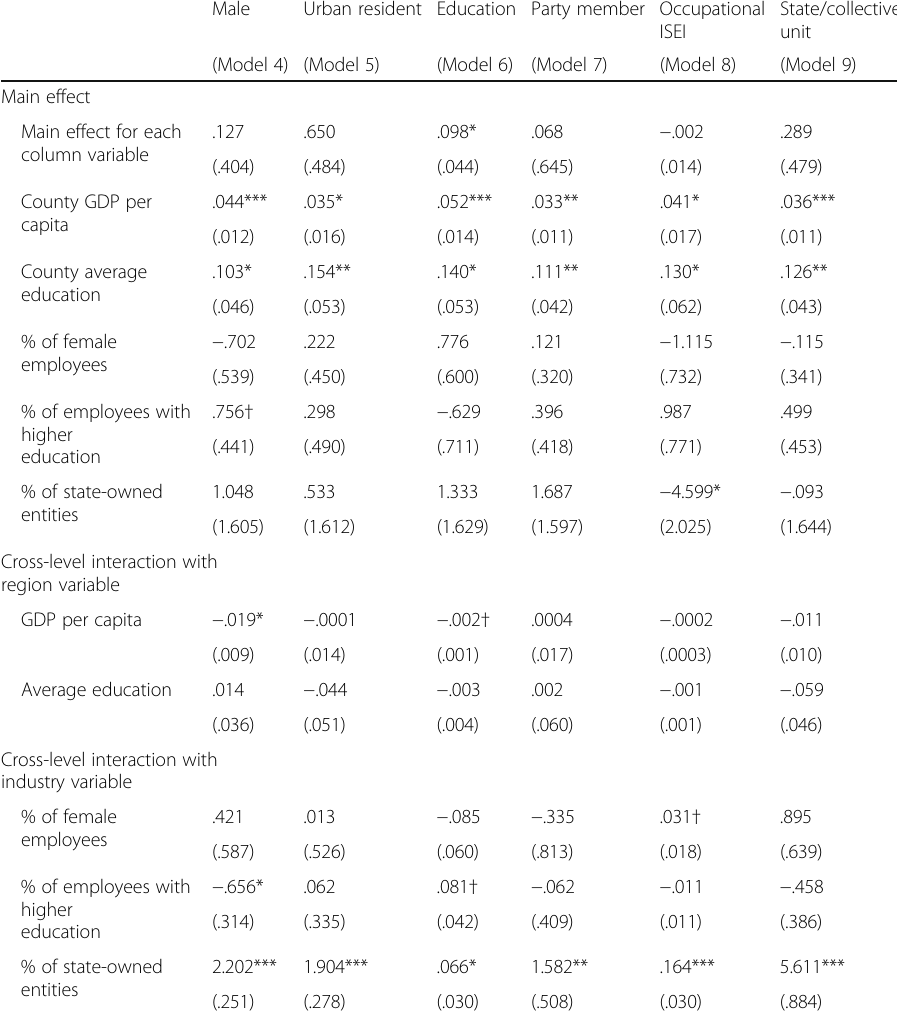
Table 4 Cross-classified multilevel model with cross-level interactions for individual monthly income (Log),